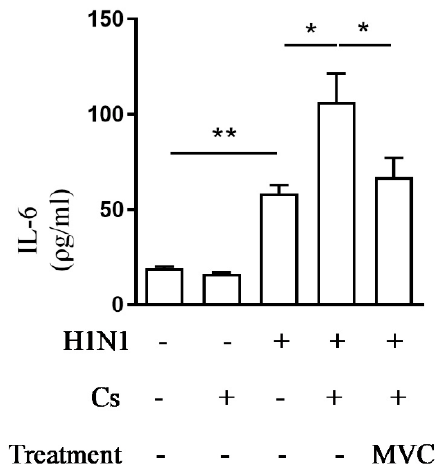
Figure 4. Maraviroc reduces IL-6 levels in mice serum. Effect of Maraviroc on IL-6 levels in the serum of mice exposed to Cs and infected with influenza A virus (CsH1N1). Data are expressed as mean ± SEM from at least 6 mice per group. * p < 0.05, ** p < 0.01. Differences were statistically evaluated One-Way ANOVA with Tukey post-test.